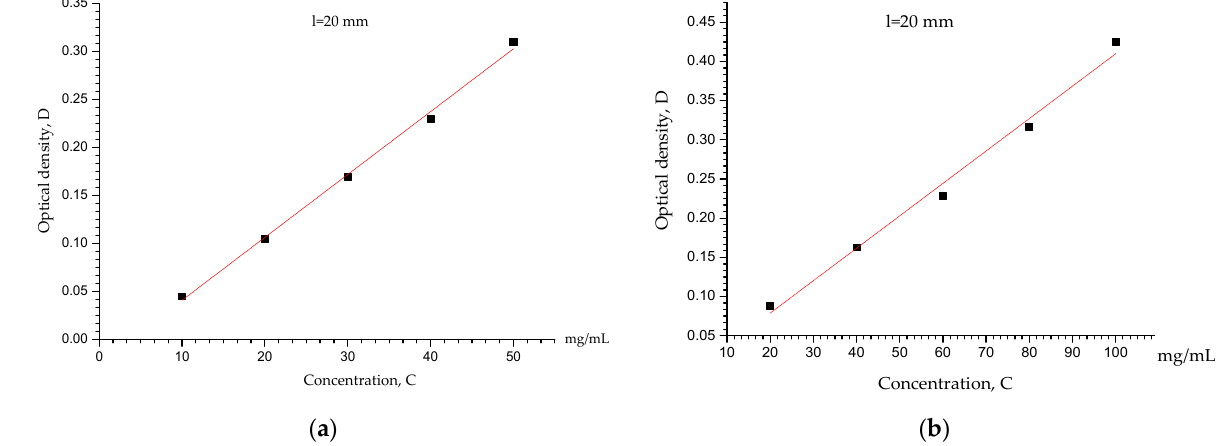
Figure 5. The calibration curves for determining the ( a ) europium(III) and ( b ) scandium(III) concen- trations in the test solutions.